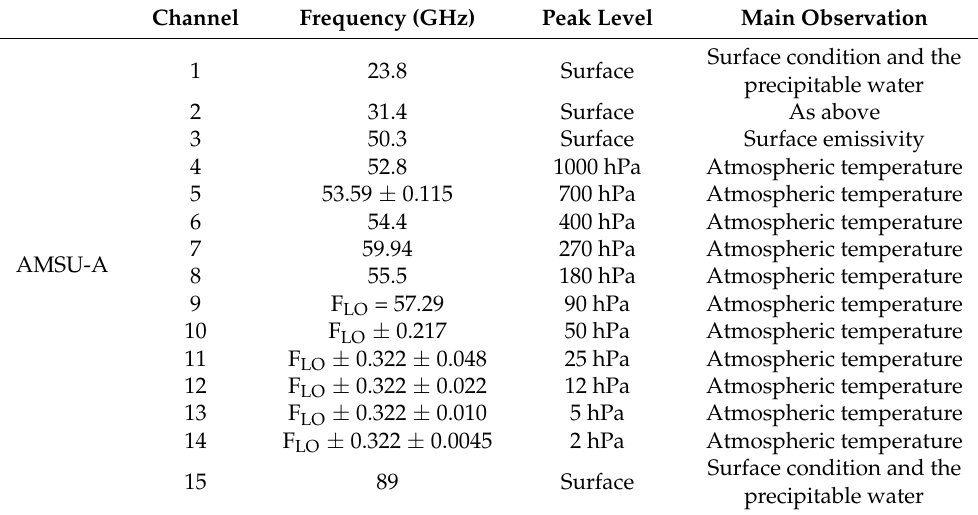
Table 1. Characteristics of the